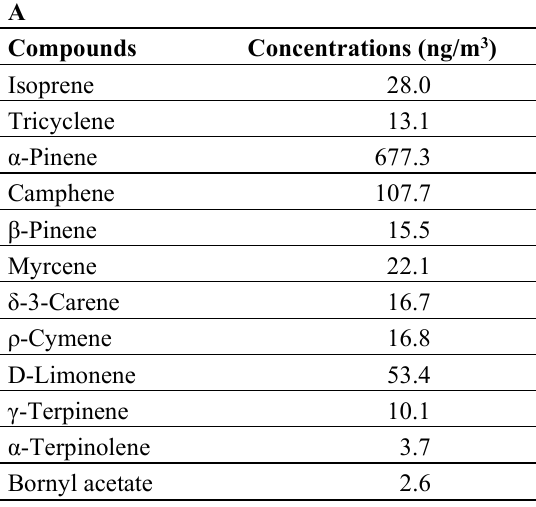
Table 2. ( A ) Terpenoids identified in rural air (Ukiha City, Japan) and ( B ) pollution products and terpenoids identified in urban air (Fukuoka City, Japan). ( A ) Rural air analysis; ( B ) Urban air